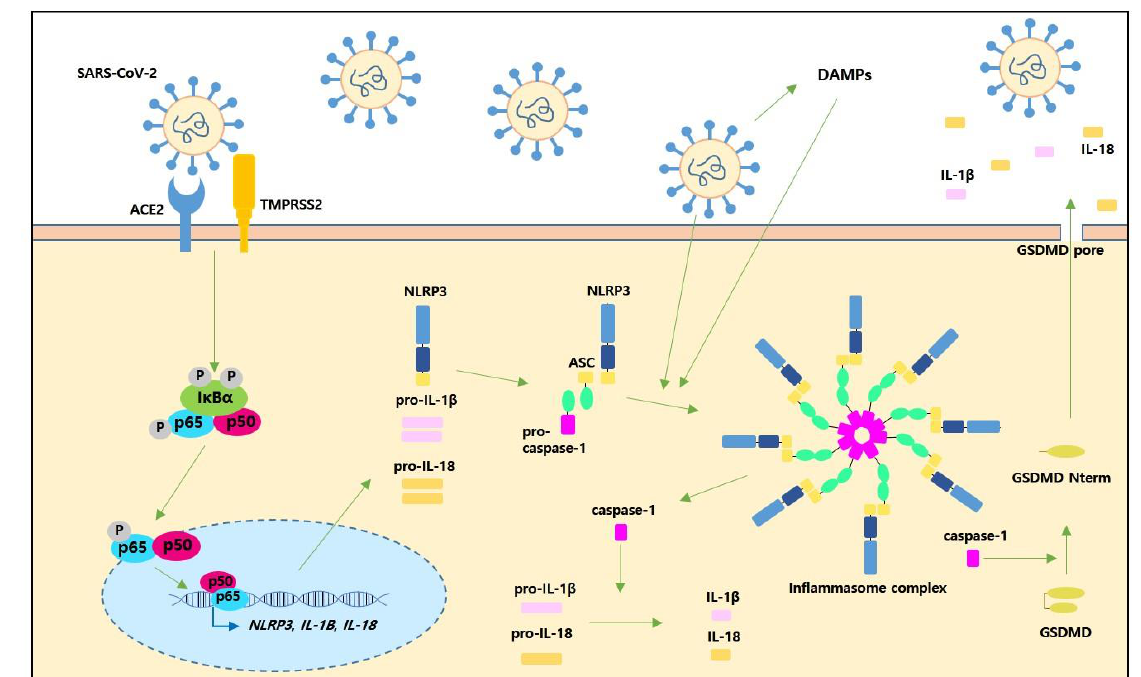
Figure 1. Possible routes of SARS-CoV-2 to activate the inflammasome complex. SARS-CoV-2 enters the cell via the angiotensin-converting enzyme II (ACE2) and transmembrane serine protease 2 (TMPRSS2). SARS-CoV-2 itself may activate the nuclear factor kappa-light-chain enhancer of activated B cells (NF-κB) signalling pathway, and NF-κB subunits are involved in the expressions of NLRP3 , IL-1B , and IL-18 . SARS-CoV-2 viroporin might activate the NLRP3 inflammasome complex. The NLRP3 inflammasome assembles with the adaptor protein ASC and pro-caspase-1. Inflammasome activation is responsible for the cleavage of caspase-1 and the promotion of IL-1β and IL-18 secretion. Cleaved caspase-1 results in the cleavage of gasdermin D (GSDMD). Cleaved GSDMD creates transmembrane pores, and IL-1β and IL-18 are secreted into the extracellular environment, ultimately leading to pyroptosis.